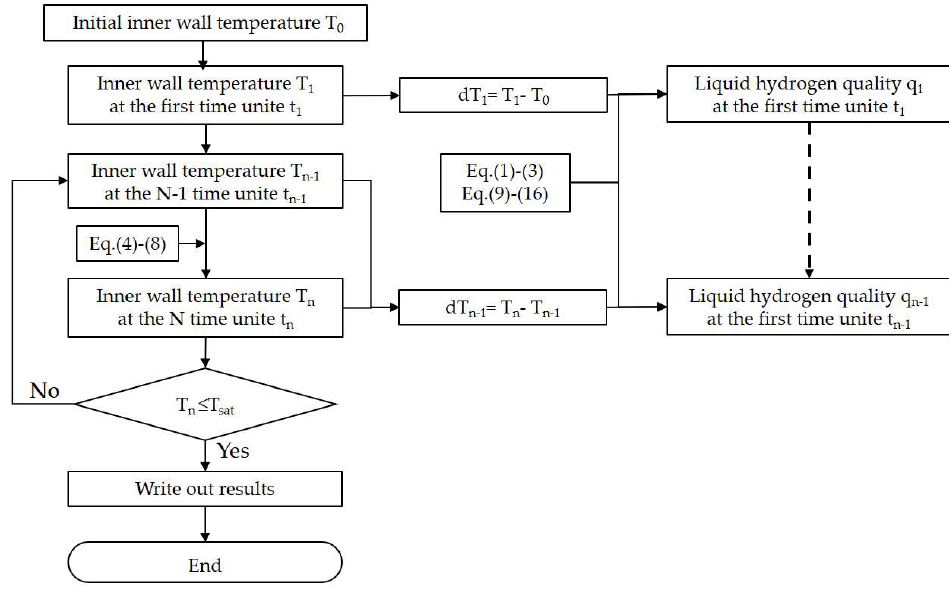
Figure 2. Flow diagram of pre-cooling parameter calculation of liquid hydrogen tank.